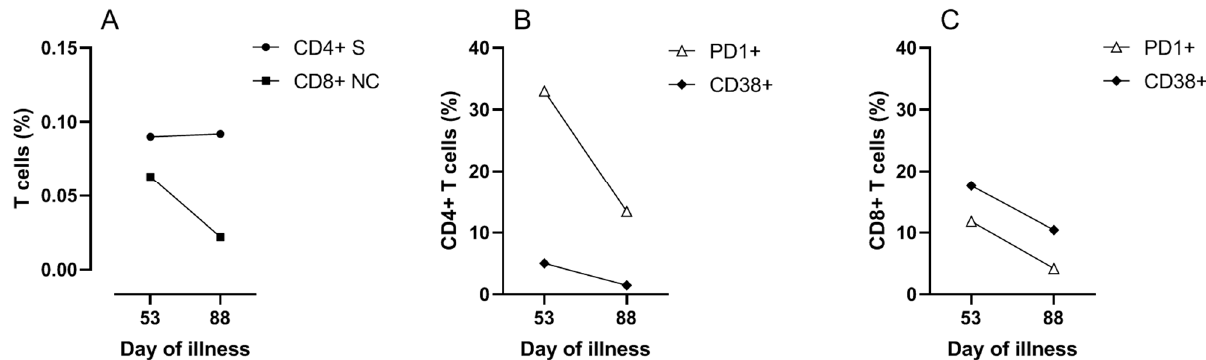
Figure 3. Reactivity and activation of SARS-CoV-2 specific T cells over time. Reactivity and activation of SARS-CoV-2 specific CD4 T cells over time. FACS analysis of T cells after overnight stimulation of PBMCs sampled on days 53 and 88 using peptides derived from SARS-CoV-2 spike (S) or nucleocapsid (NC) protein. ( A ) Reactivity of CD4 T cells towards the S protein (CD4 S) and reactivity of CD8 T cells towards the NC protein (CD8 NC) is shown as % CD154+TNF α + of total CD4+ T cells, or as % CD137+IFN γ + of total CD8+ T cells, respectively. ( B ) Frequency of activation marker (PD1 and CD38) positive SARS-CoV-2 reactive CD4+ T cells over time. ( C ) Frequency of activation marker (PD1 and CD38) positive SARS-CoV-2 reactive CD8+ T cells over time.